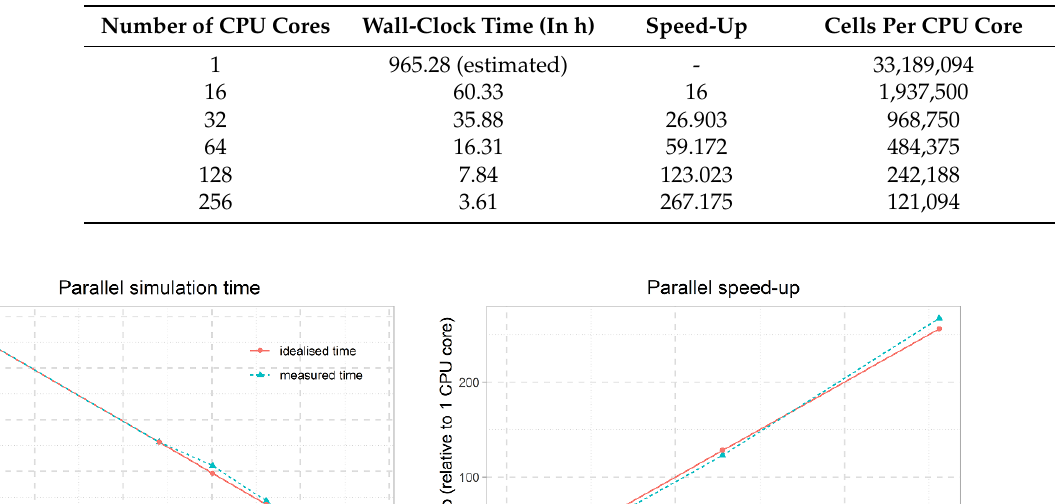
Table 3. Results of the strong scalability test of a case with 31 million cells.